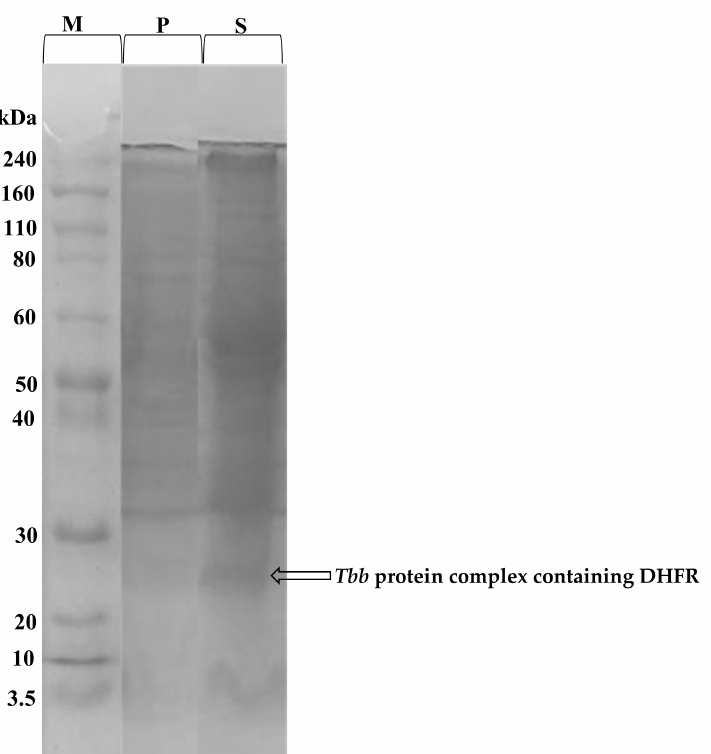
Figure 5. Coomassie blue stained SDS-PAGE gel showing the proteins eluted from T. b. b. lysates. T. b. b. total protein extract was submitted to SDS-PAGE to confirm the efficiency of the protein extraction protocol. T. b. b. crude extract was run at 12% resolving and 4% stacking gels at